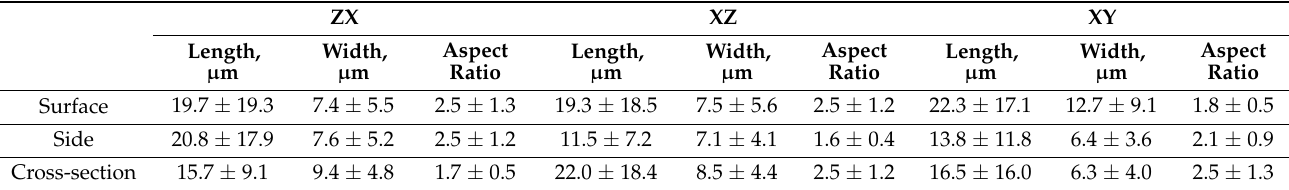
Table 1. Statistic information from the EBSD analysis about the length, width, and aspect ratio of grains for different specimen